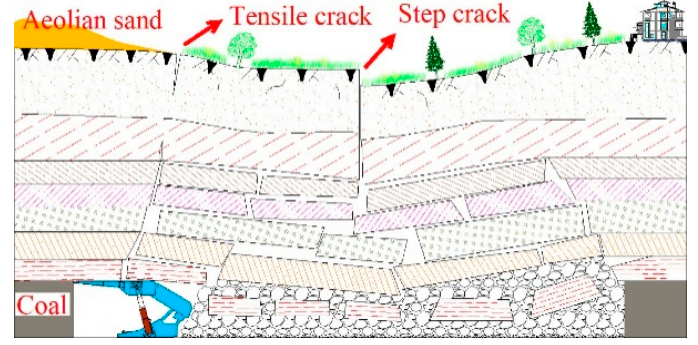
Figure 1. “Two-zone” model in overlying strata under high-intensity mining.